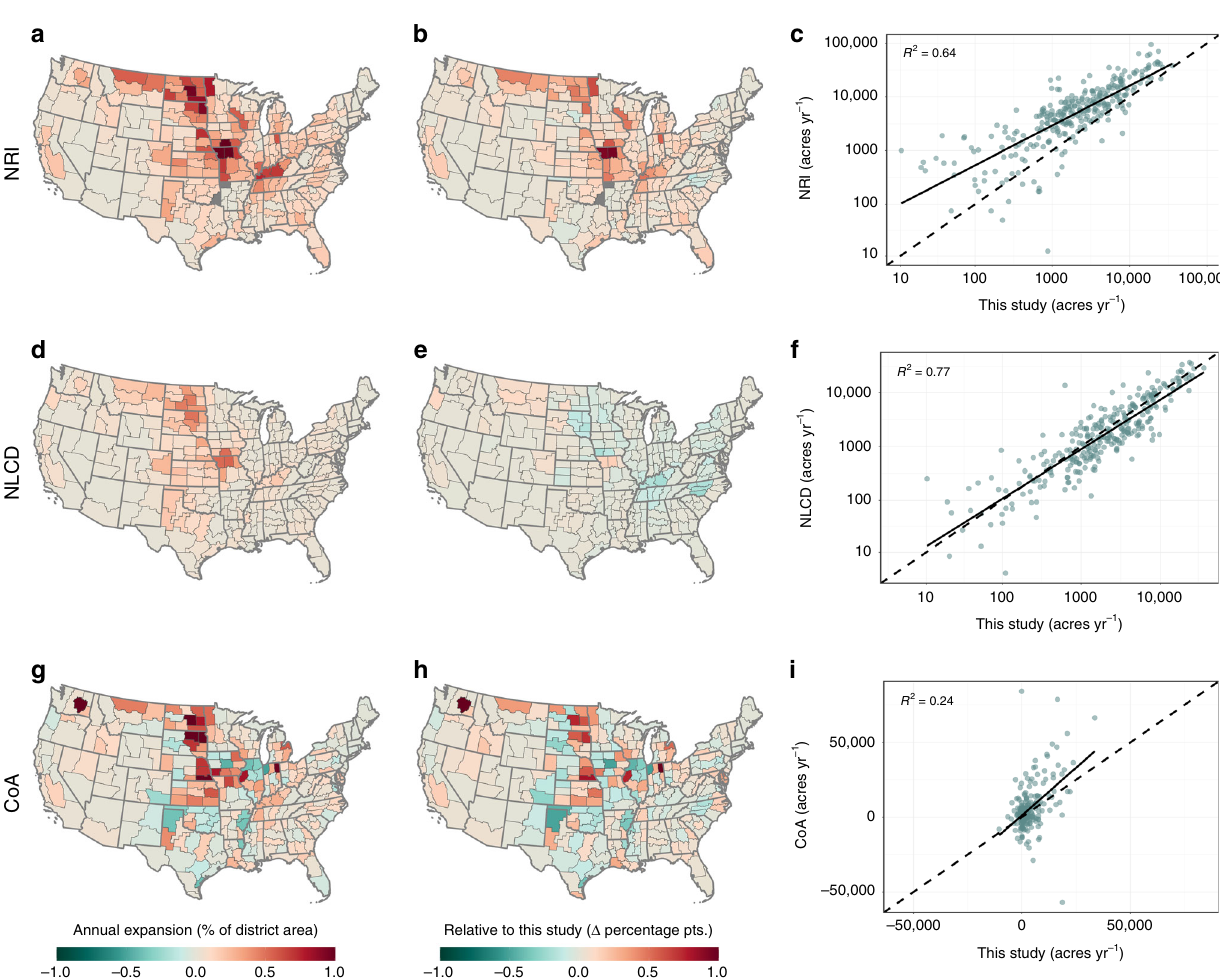
Fig. 7 Comparison to other recent cropland expansion estimates. Average annual rates of cropland expansion derived from the National Resources Inventory (NRI) 2007 – 15 ( a – c ), the National Land Cover Database (NLCD) 2008 – 16 ( d – f ), and the Census of Agriculture (CoA) 2007 – 17 ( g – i ). Maps in the fi rst column ( a , d , g ) depict the annual rate at which croplands expanded within each agricultural district, calculated as a percentage of the total district area. Maps in the second column ( b , e , h ) show how these annual rates differ in absolute terms ( Δ percentage points) from the comparable estimates derived in this study. Scatterplots in the third column ( c , f , i ) illustrate how absolute annual rates of expansion within each district (acres yr − 1 ) from each data source compare to those in this study. The R 2 value for each linear regression is listed on the corresponding plot, with full regression statistics and state-level results reported in Supplementary Table 6 and Supplementary Fig. 14. Note that NRI and NLCD estimates and comparisons to this study are based on rates of gross cropland expansion; CoA estimates and comparisons based on rates of net cropland change. All three comparison datasets — based on unique sources — corroborate the general trend and spatial patterns observed in this study of widespread cropland expansion throughout the US over approximately the past